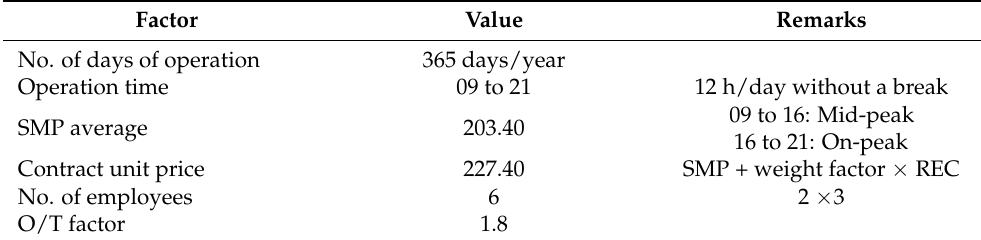
Table 35. Factors and their values are subject to the operation plan (Scenario VI).